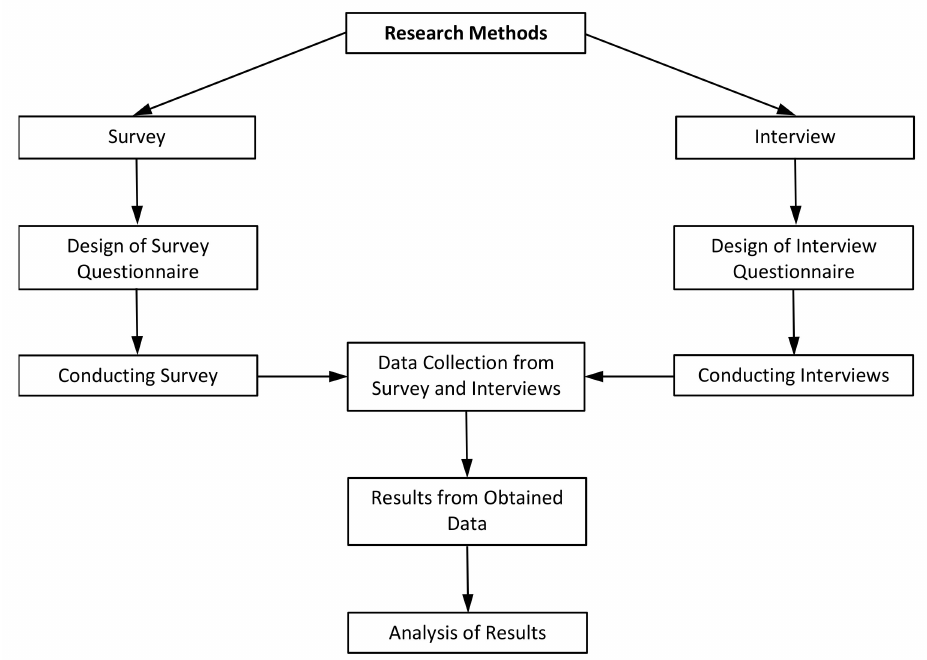
Figure 1. Overall research